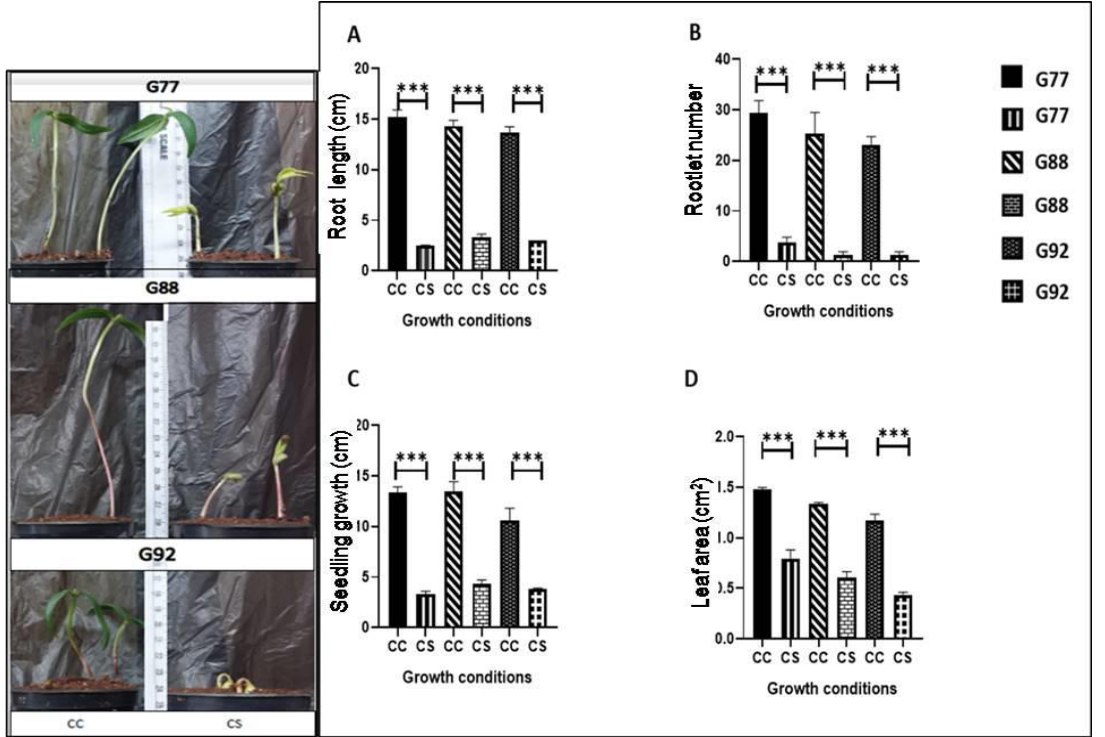
Figure 5. Seedling phenotypes of G-77 (PAU 911), G-88 (PUSA 1672), and G-92 (PUSA 9531) under Cold Stress (CS). Seedling phenotypes (picture panel) such as ( A )Root length ( B ) Rootlet number and ( C ) Seedling length ( D ) Leaf area were measured in 8-day-old seedlings grown at 10 °C. Data represented were mean of 10 measurements for each with 3 biological replicates. Statistical significance using one- way ANOVA indicated as *** p < 0.0001.